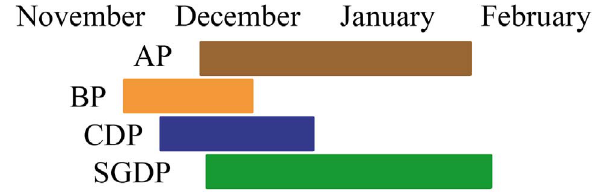
Figure 2. Incubation period of the four small petrels in Bird Island during austral summer 2010/11. Antarctic prion (AP), blue petrel (BP), common diving petrel (CDP) and South Georgian diving petrel (SGDP).